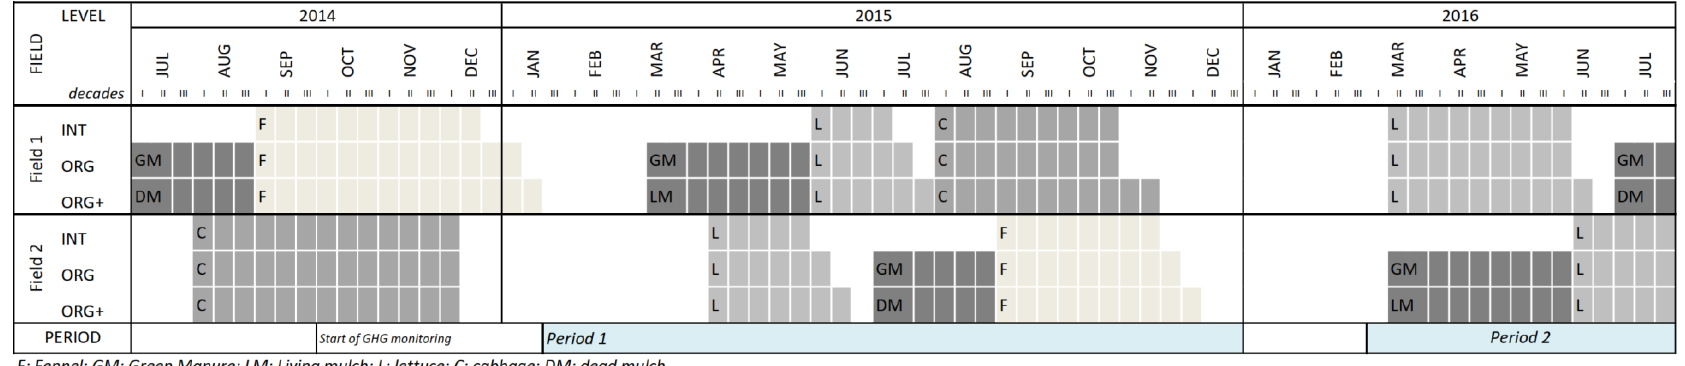
Figure 1. Presence of the crops in rotation in the three cropping systems (integrated farming (INT), organic farming (ORG) and organic-conservation farming (ORG+)) in the two fields, with the calendar of soil greenhouse gas (GHG) monitoring. Soil GHG data from periods identified as Period 1 (P1) and Period 2 (P2) were used to calculate daily and cumulative emissions.